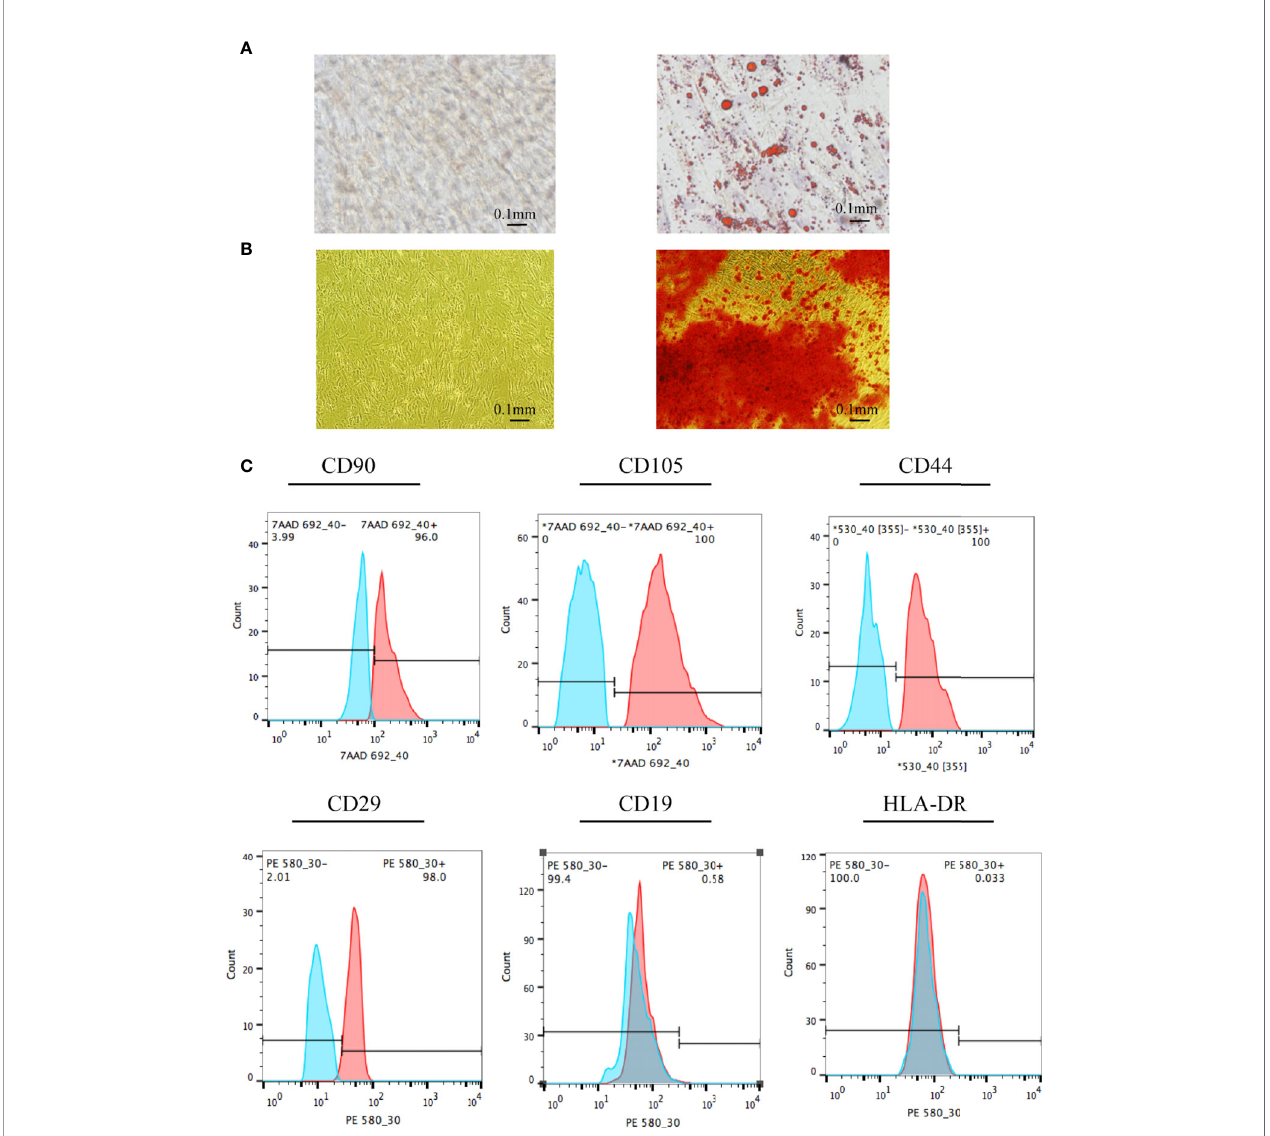
FIGURE 1 | Identi fi cation of UC-MSCs. (A) UC-MSCs were exposed to adipogenic differentiation medium and stained by Oil Red O. Compared to cells in the control group, the red, round lipid droplets observed in UC-MSCs treated with adipogenic differentiation medium con fi rms their differentiation into adipocytes. (B) UC-MSCs were cultured with osteoblast differentiation medium and stained by Alizarin Red S. As evidenced by the red round droplet in the righthand image, UC-MSCs could differentiate into osteocytes. (C) Stem cell phenotypes were identi fi ed by fl ow cytometry. Positive indicators (CD90, CD105, CD44, and CD29) showed that the cells to be tested were stem cells rather than ordinary cells. In addition, negative markers (CD19 and HLA-DR) showed that the cells to be tested were mesenchymal stem cells rather than hematopoietic stem cells. All experiments were repeated three